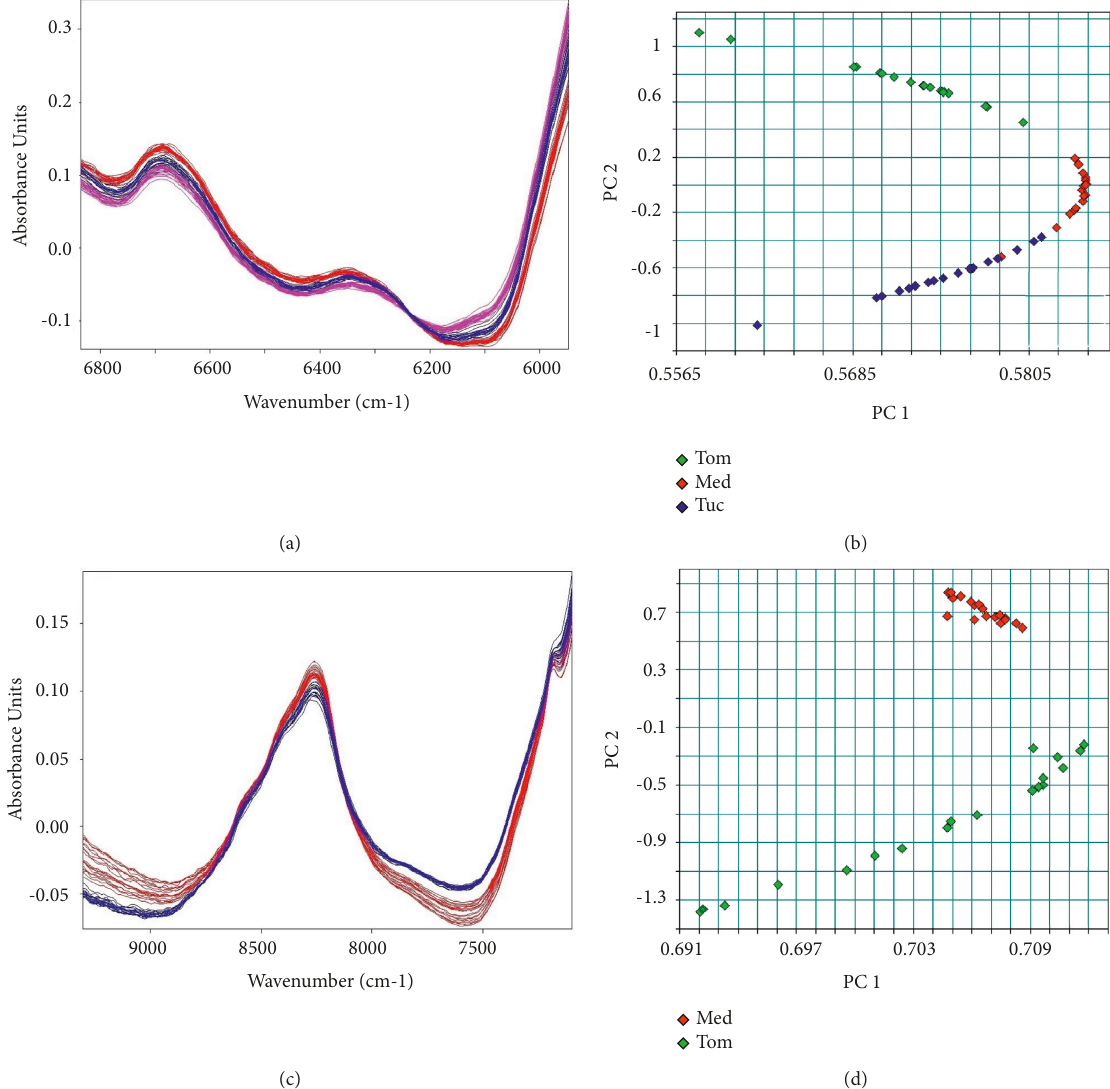
Figure 4: The absorption spectrum of the DFD separation regions (a, c) and their respective scores (b, d), for the two selected optimal separation